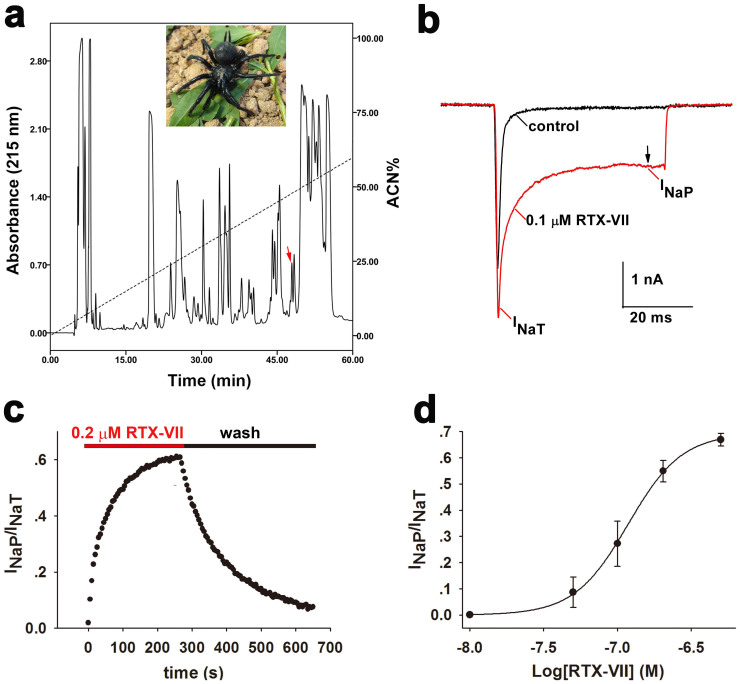
RTX-VII induces large INaP in Nav1.3.(a) RP-HPLC profile of the venom from the spider Macrothele raveni (inset, photo by Dr Songping Liang), where red arrow indicates the fraction containing RTX-VII. (b) Current traces from a representative cell show 0.1 μM RTX-VII enhances the INaT of Nav1.3 and induces a large INaP at the end of a 50-ms depolarization to −10 mV from a holding potential of −100 mV (n = 6). Note INaP was measured at the time point of 45 ms. (c) Time course for the enhancement of INaP of Nav1.3 by 0.2 μM RTX-VII and the recovery upon washing with bath solution, τon and τoff is 40.9 ± 11.3 s and 162.8 ± 39.7 s, respectively (n = 4). (d) RTX-VII dose dependently enhances INaP of Nav1.3 with an apparent EC50 of 0.12 μM (n = 6). The maximum response (fmax) and the minimum response (fmin) of Nav1.3 to RTX-VII is 66.90% and 0, respectively.